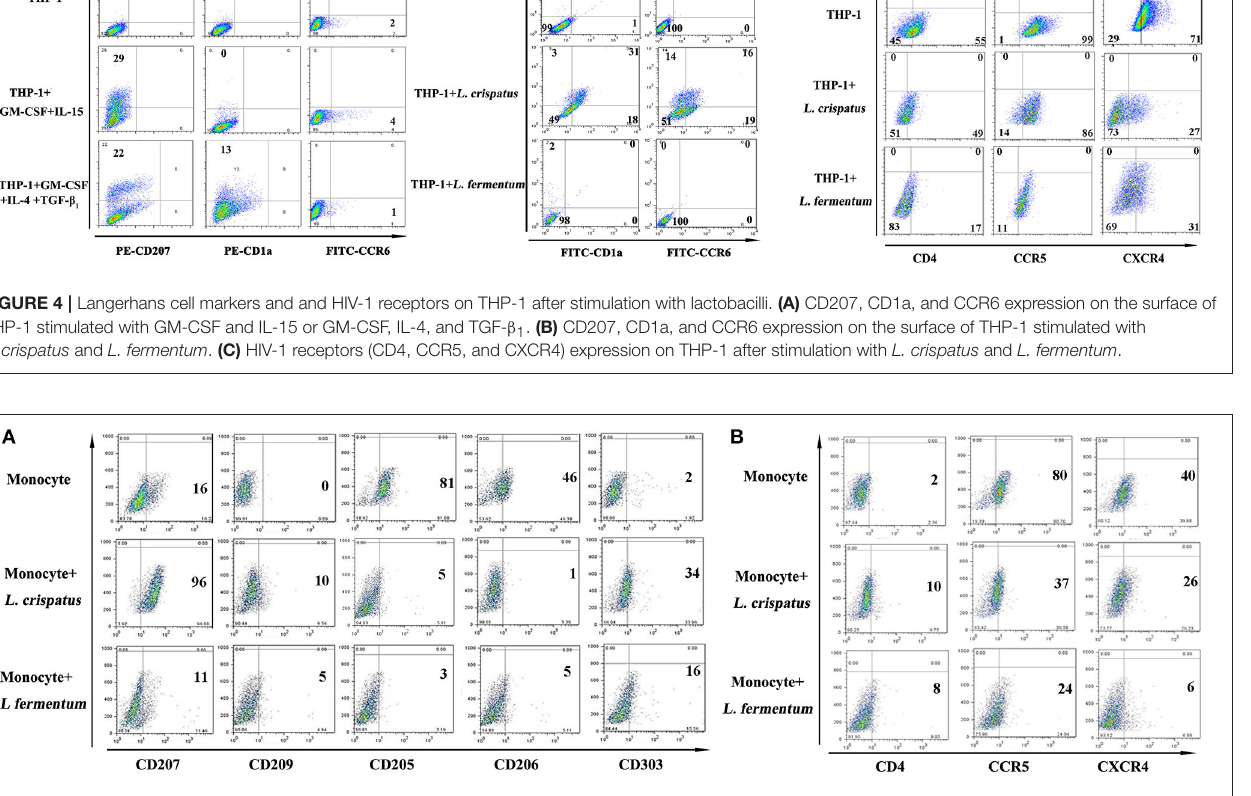
FIGURE 5 | C-type lectins and HIV receptors in CD14 + monocytes after incubation with L. crispatus and L. fermentum. (A) Flow cytometry results showed CD207, CD209, CD205, CD206, and CD303 expression on CD14 + monocytes stimulated with L. crispatus and L. fermentum compared with unstimulated monocytes. (B) HIV-1 receptor (CD4, CCR5 and CXCR4) expression on CD14 + monocytes after stimulation with L. crispatus and L. fermentum